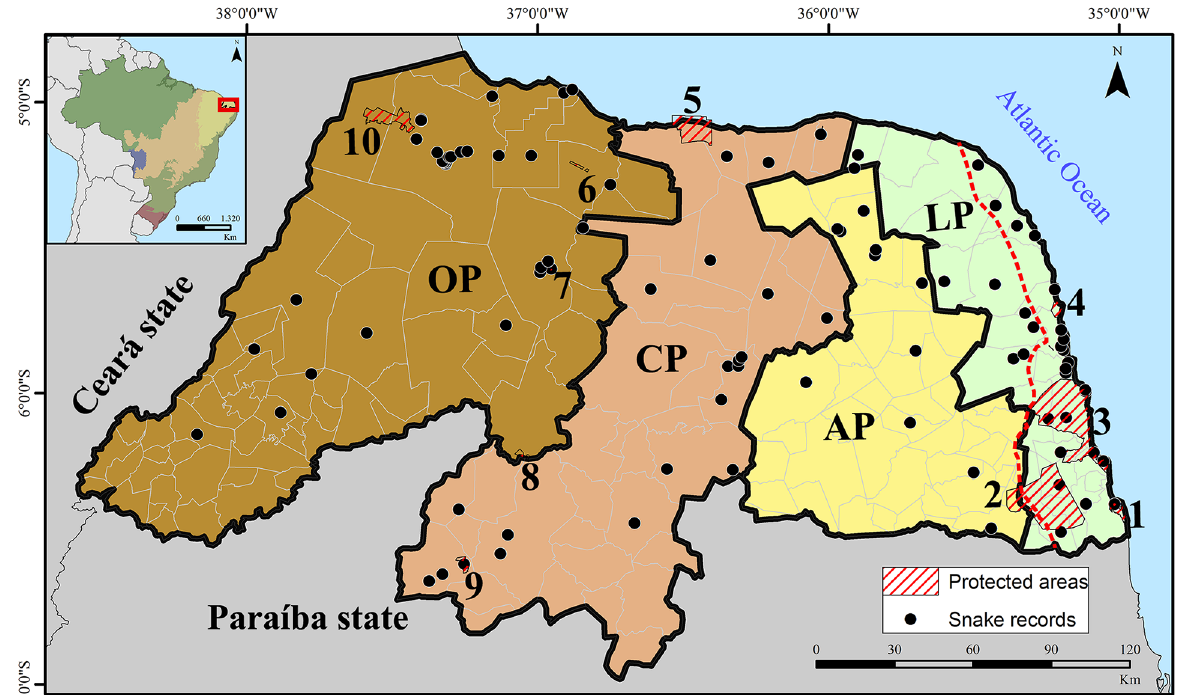
Figure 1. Map showing Rio Grande do Norte state and its four geographic mesoregions: Oeste Potiguar (OP), Central Potiguar (CP), Agreste Potiguar (AP), and Leste Potiguar (LP). The red dashed line shows the boundaries between Caatinga (left) and Atlantic Forest (right) biomes. Black dots represent snake records, hatched polygons show protected areas: RPPN Mata Estrela (private reserve) (1), APA Piriqui-Una protection area (2), APA Bonfim/Guaraíra protection area (3), APA Jenipabu (4), RDS Ponta do Tubarão (5), RPPN Esperança (6), FLONA Açu (7), RPPN Fazenda Salobro Farm (8), ESEC Seridó (9), PN Furna Feia (10). Protected area acronym, in increasing order of protection: APA (Área de Proteção Ambiental – Environmental Protection Area); RDS (Reserva de Desenvolvimento Sustentável – Sustainable Development Reserve); FLONA (Floresta Nacional – National Forest); RPPN (Reserva Particular do Patrimônio Natural –Private Reserve of the Natural Heritage); PN (Parque Nacional – National Park); ESEC (Estação Ecológica – Ecological